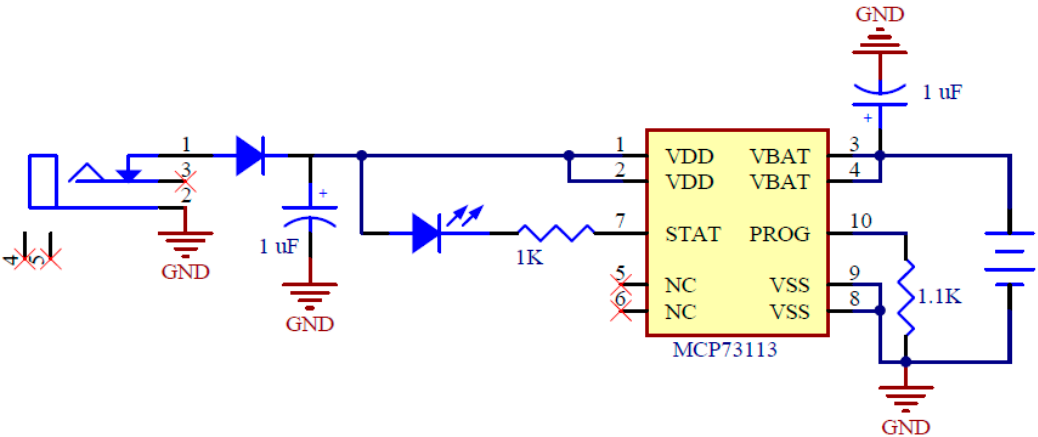
Figure 2. Electrical diagram of battery charging system corresponding to prototype version 2 (PV2).